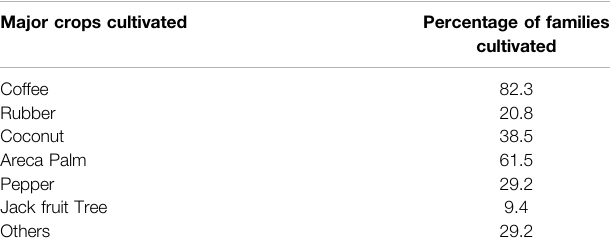
TABLE 1 | Crops cultivated by